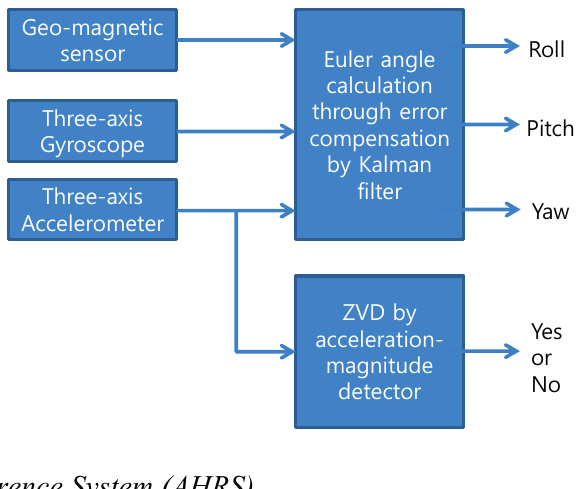
Figure 3. A block diagram of a motion sensor for